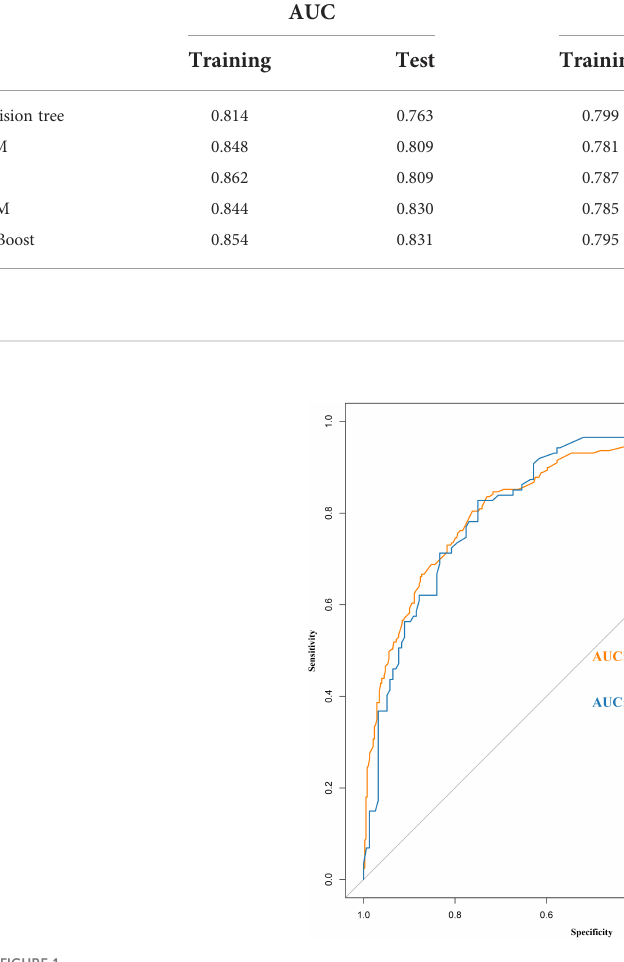
FIGURE 1 Receiver operating characteristic (ROC) curves of the XGBoost model in the training and the test set.